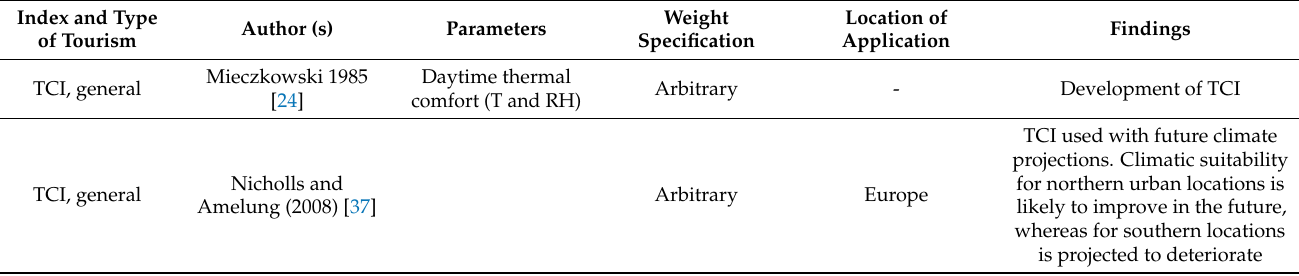
Table 1. Overview of scientific literature on climate comfort indices and conditions for